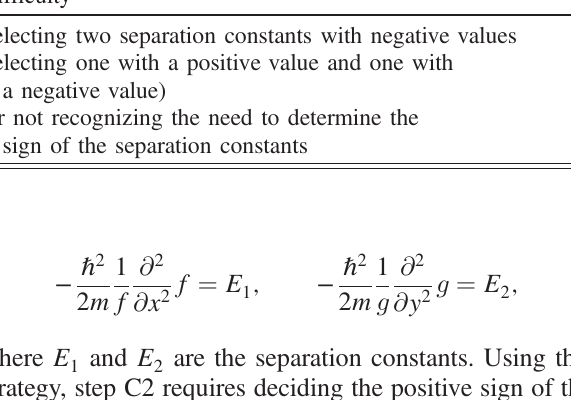
TABLE III. Difficulties in step C3: setting up expressions to match the boundary conditions.